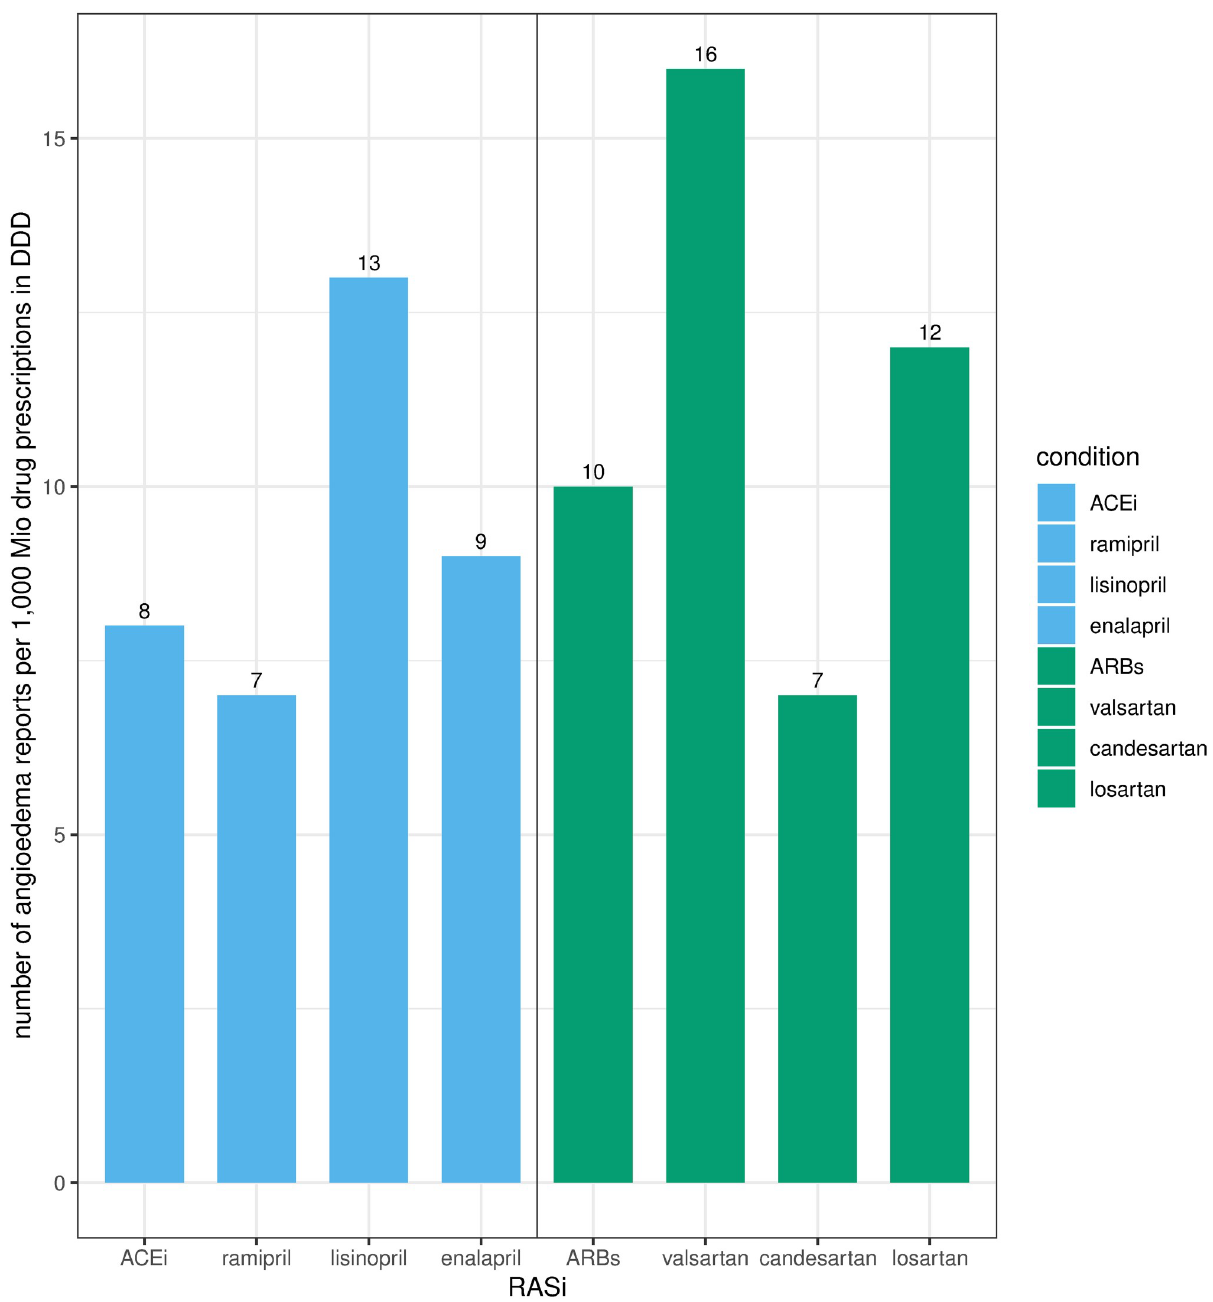
Fig 2. Number of ACEi , ARBs , and aliskiren angioedema cases per 1,000 Mio drug prescriptions in DDD (2010–2016). Fig 2 shows the number of angioedema reports per 1,000 Mio drug prescriptions in DDD for ACEi, and ARBs. For aliskiren, 154 angioedema reports per 1,000 Mio drug prescriptions were calculated. The number is not depicted in Fig 2 in order to make the difference between the respective drug substances of ACEi and ARBs clearer. The complete presentation of the number of cases and the number of drug prescriptions used for the calculation of the number of angioedema reports per 1,000 Mio drug prescriptions in DDD is contained in S6 Table. Our result deviates from existing literature. With regard to a meta-analysis of randomized trials for renin-angiotensin system inhibitors associated angioedemas, the incidences for ACEi were 0.30% for ARBs 0.11% and for aliskiren 0.13% [23]. The limitations of spontaneous reporting systems have to be considered.